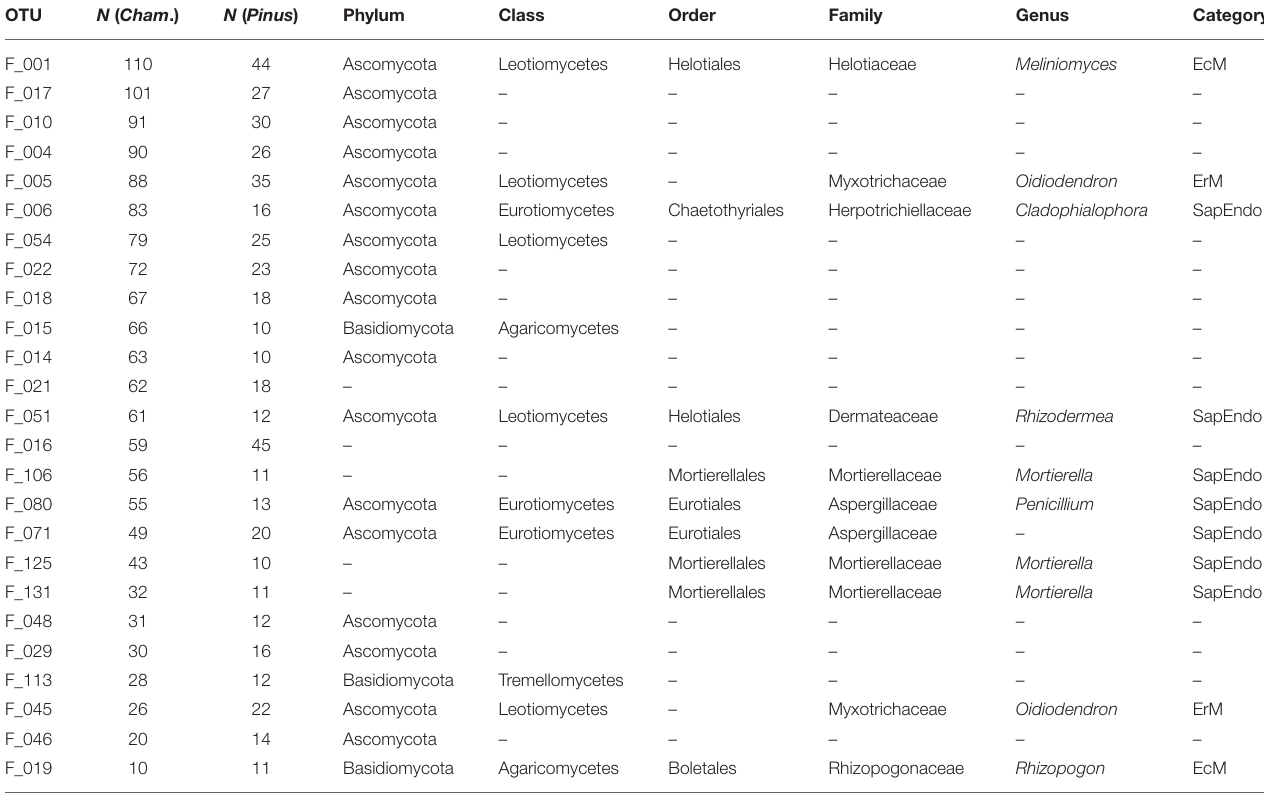
TABLE 1 | Fungal OTUs commonly found from both Chamaecyparis and Pinus roots. OTU N ( Cham